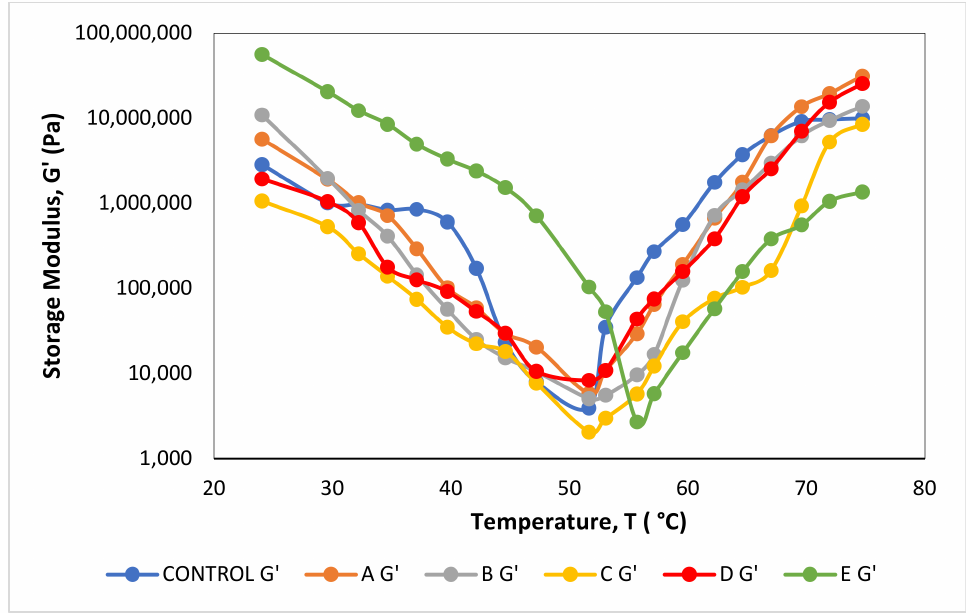
Figure 4. Storage modulus (G (cid:48) ) of fat-replaced samples with palm shortenings (PS) of various melting ranges (MR) as compared to the control sample with chicken skin as a function of